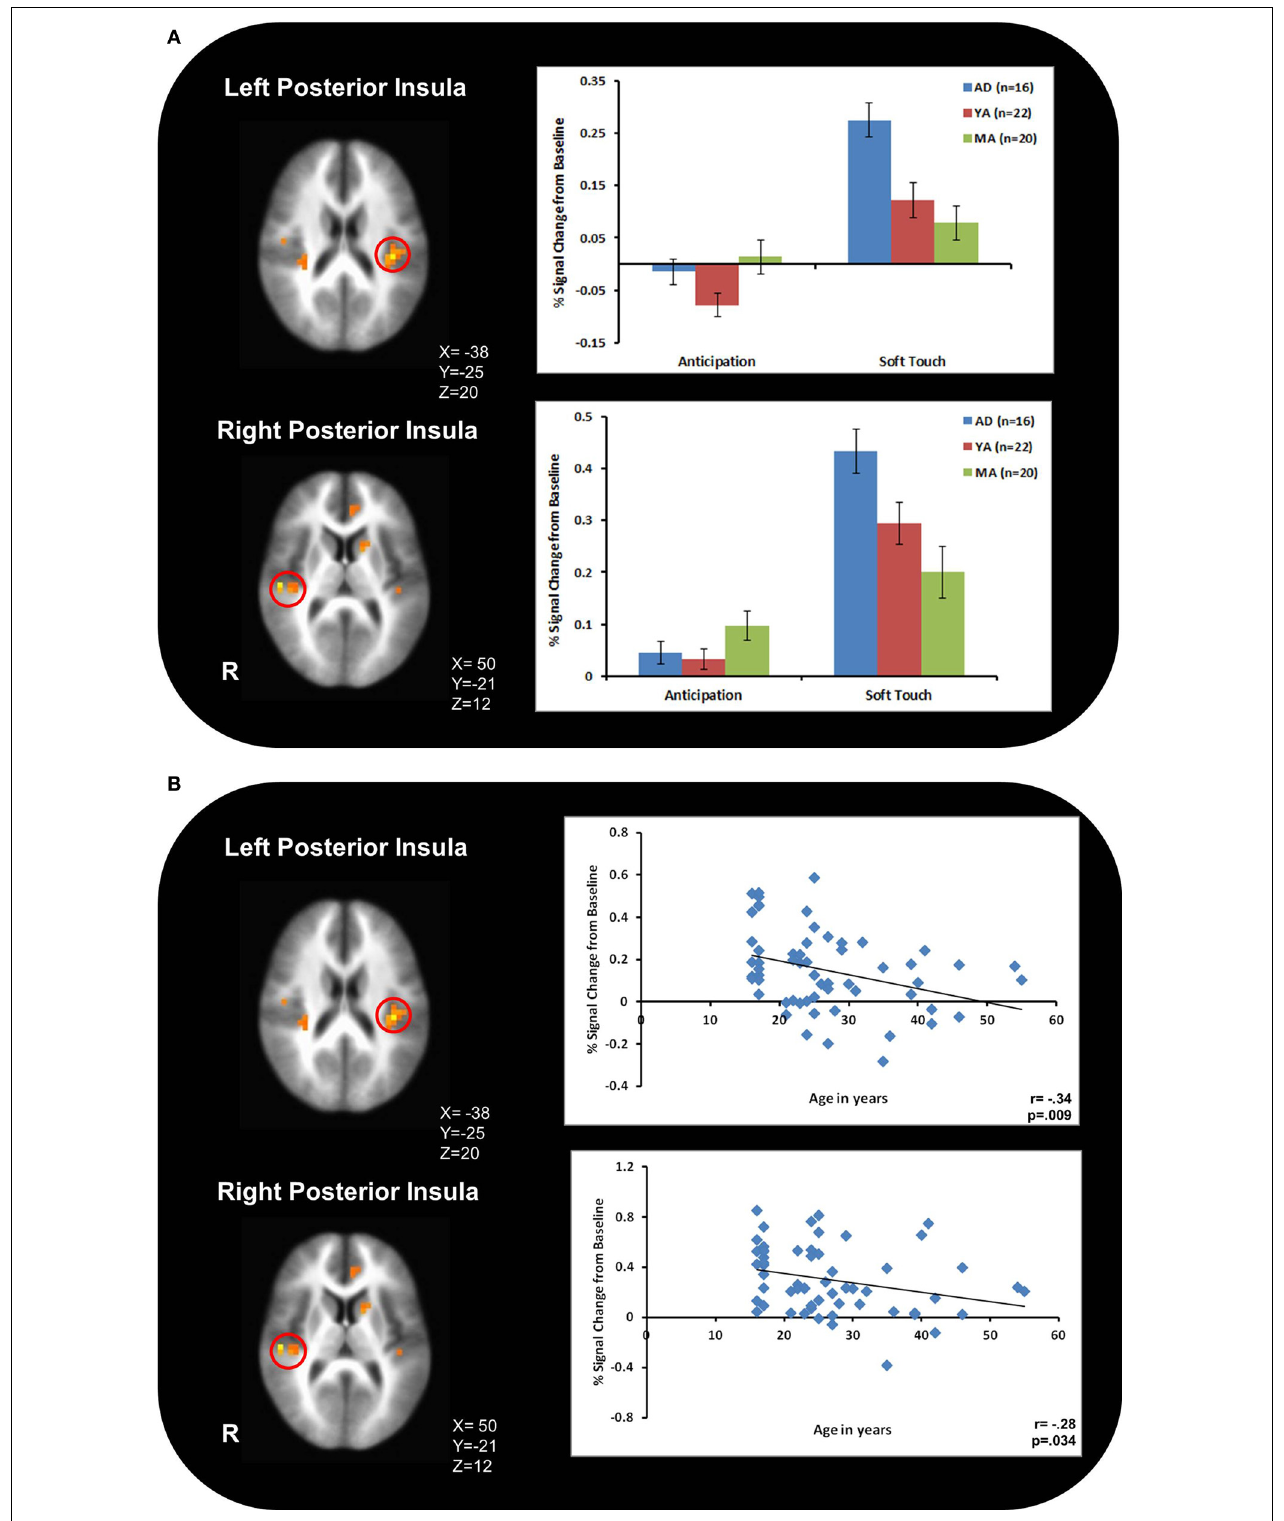
FIGURE 3 | (A) During the soft touch condition, adolescents, (AD) displayed greater activation than young adults (YA) and mature adults (MA) in bilateral posterior insula. (B) The relationship between age and bilateral posterior insula activation showed a significant negative